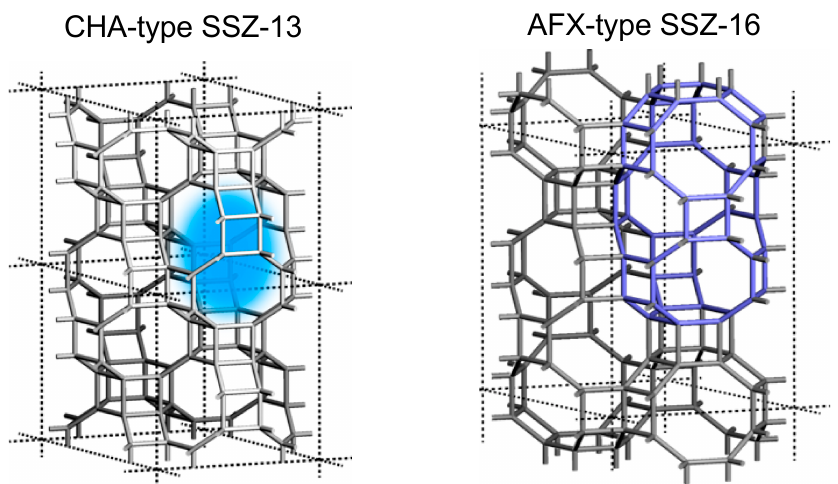
Figure 10. Frameworks of CHA-type SSZ-13 ( left ) and AFX-type SSZ-16 ( right ).